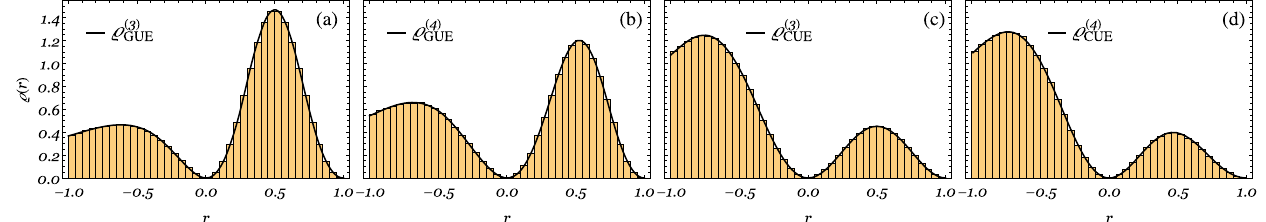
FIG. 13. Comparison of exact diagonalization (ED) for GUE- and CUE-drawn random matrices with analytical results. (a) N ¼ 3 GUE, black line given by Eq. (B8), with β ¼ 2 ; (b) N ¼ 4 GUE, black line given by Eq. (B12); (c) N ¼ 3 CUE, black line given by Eq. (B17); (d) N ¼ 4 CUE, black line given by Eq.